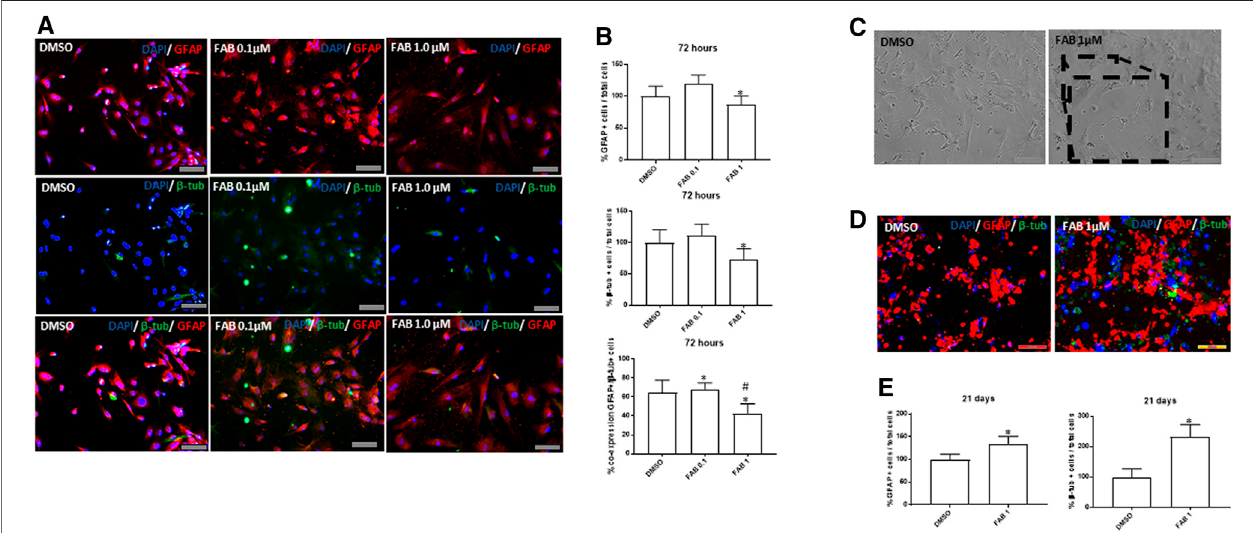
FIGURE3| AnalysisoftheexpressionofneuralmarkersGFAP(red)and β -tubulinIII( β -tub,green)inratbonemarrow-derivedmesenchymalstemcells(rMSCs). (A) Photomicrographies of cultures in control conditions (0.01% DMSO) and 72 h after treatment with agathis fl avone (0.1, 1 µM FAB); immunocytochemistry; scale bar 100 µm.NotethatthereisandiscretincreasecomparetocontrolintheproportionofGFAP+cellsdistributedinthecellbodyof fl atpolygonalcellsinculturesexposedto 0.1 µMFAB,withsomepolygonalcellsco-expressing β -tub,typicalofneuralprogenitorcells.Sucheffectwasnotobservedattheextensioninculturesexposedto 1 µM FAB. (B) Quanti fi cation of the proportion of GFAP + cells and β -tub + cells related to the total of cell nuclei counted by DAPI-stained nucleus (blue); the results are expressed as the percentage of means ± SD related to control, considered as 100%, in three independent experiments and were analyzed by Kruskal – Wallis ANOVA, followed by Turkey ’ s test for multiple comparisons (*) representing p ≤ 0.05 compared to control; (C) Morphological analysis of rMSCs maintained 21 days in control conditions(0.01%DMSO)ortreatedwithasingledoseof1 µMFAB;obj.x20,scalebar100 µm.Intheinsertsofimageatobj.40x,onecanseesomecellswithneuronal morphology, presenting cellular process similar to neurites and interacting with other cells. (D) Photomicrographies of cultures in control conditions (0.01% DMSO) and 72 h after treatment with agathis fl avone (1 µM FAB); immunocytochemistry, obj. x20, scale bar 100 µm. Note that there is an increase in the proportion of cells co- expressingGFAPand β -tubcomparedtocontrolcultures,whichiscon fi rmedin (E) byquantifyingtheproportionofGFAP+/ β -tub+cells,relatedtothetotalofcellnuclei; the results are expressed as the means of percentage in three independent experiments and analyzed by Kruskal – Wallis ANOVA followed by Turkey ’ s test for multiple comparisons (*) representing p ≤ 0.05 compared to